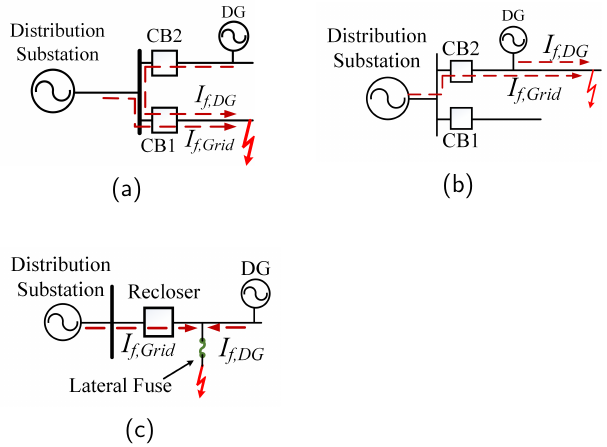
Figure 1. Fault current contributions for: ( a ) a fault on a neighboring feeder; ( b ) a downstream fault; ( c ) a fault on a lateral